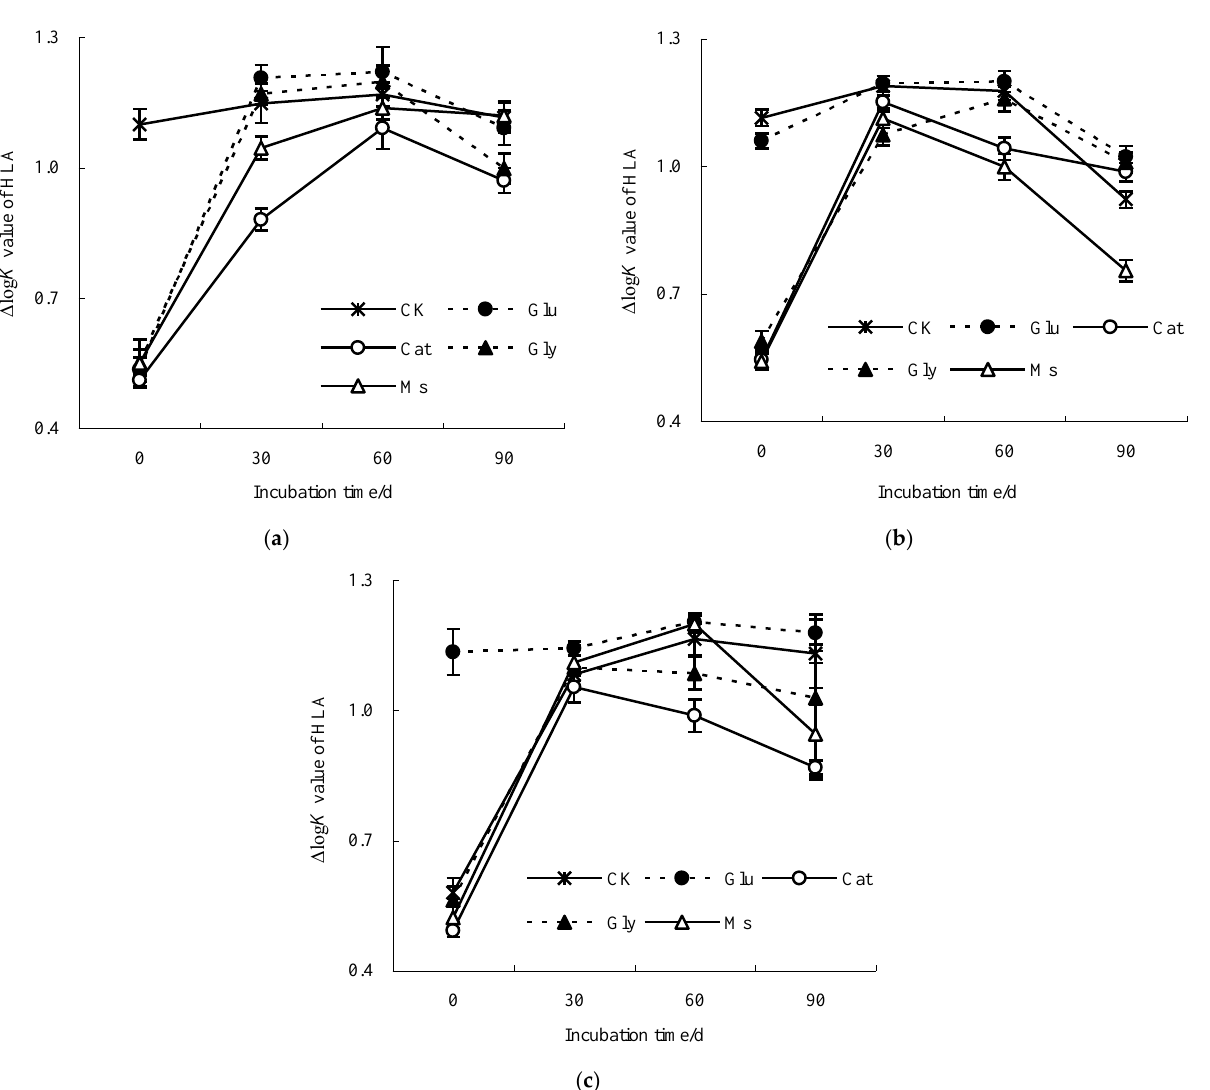
Figure 4. ∆log K value of humic-like acid liquid sample from the decomposing material of rice straw at different incubation temperatures. ( a ) Incubated at 10 °C; ( b ) incubated at 15 °C; ( c ) incubated at 28 °C.